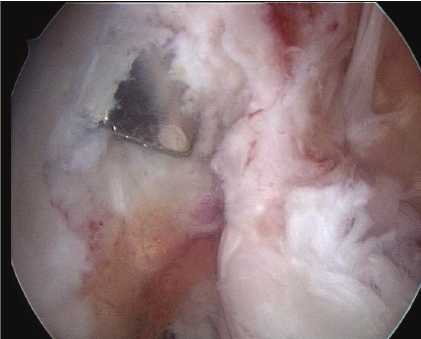
Figure 2: Arthroscopic view of the intercondylar notch showing the presence of the staple. There was space left for an anatomical femoral tunnel but there was concern with the staple affecting graft